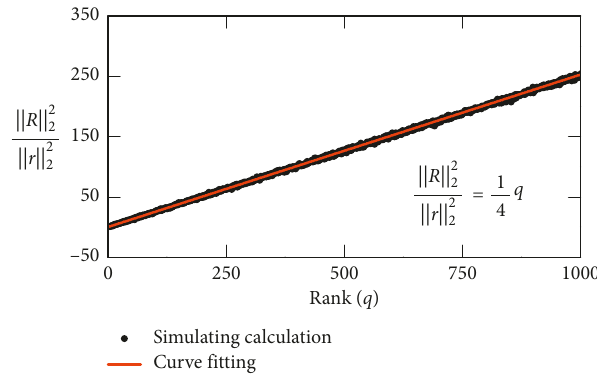
Figure 22: Simulation results and its curve